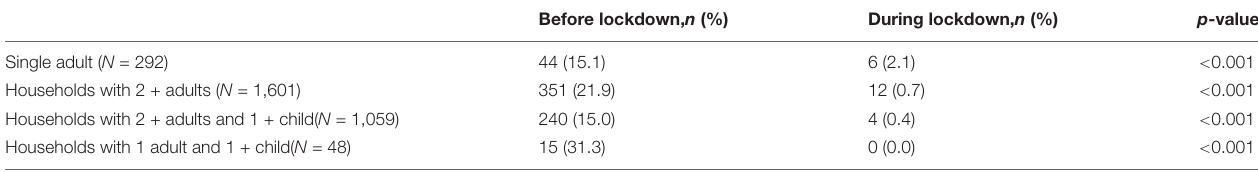
TABLE 5 | Frequently a used delivery or takeaway services before and during lockdown.